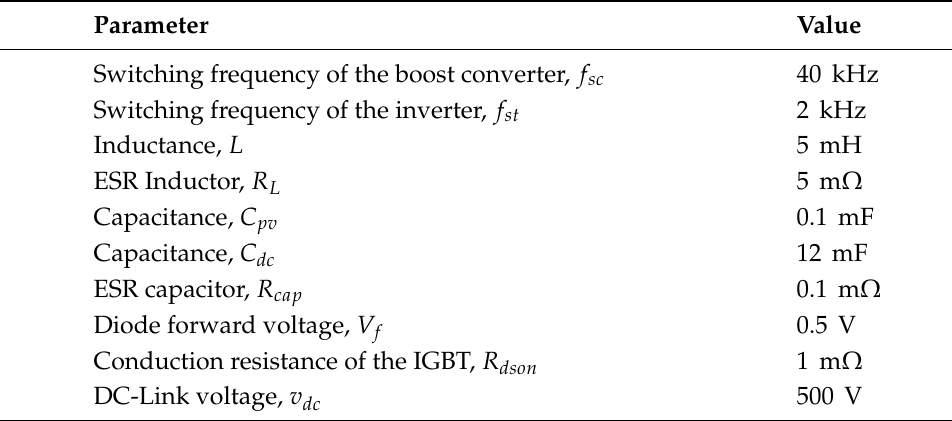
Figure 14. Comparison of efficiency curve obtained by curve fitting and test points at 25 ◦ C and 1000 W/m 2 . Table 3. Circuit parameters of two-stage